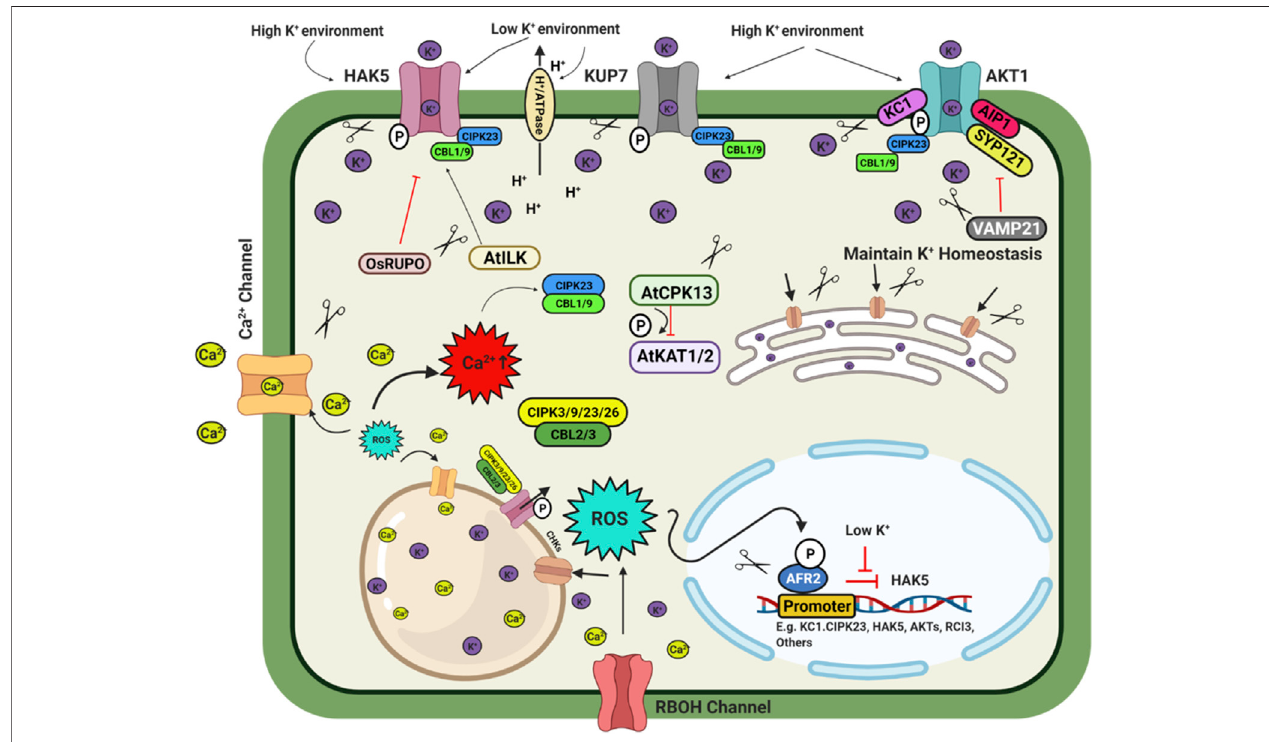
FIGURE 3 | Schematic model depicting plant response to potassium availability and signaling. Illustration was made with Biorender (https://biorender.com/). The negative regulators for targeted genome editing are indicated with a scissor sign.